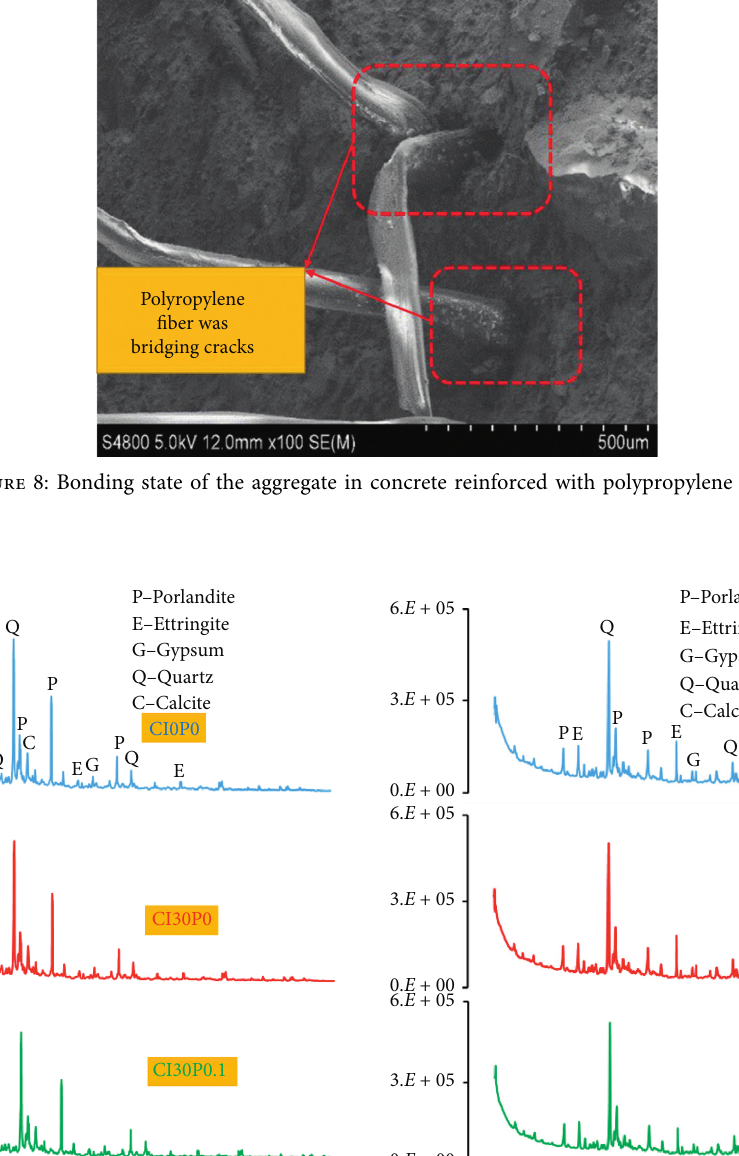
2 SO 4 solution: (a) 28 days. (b) 140 days.